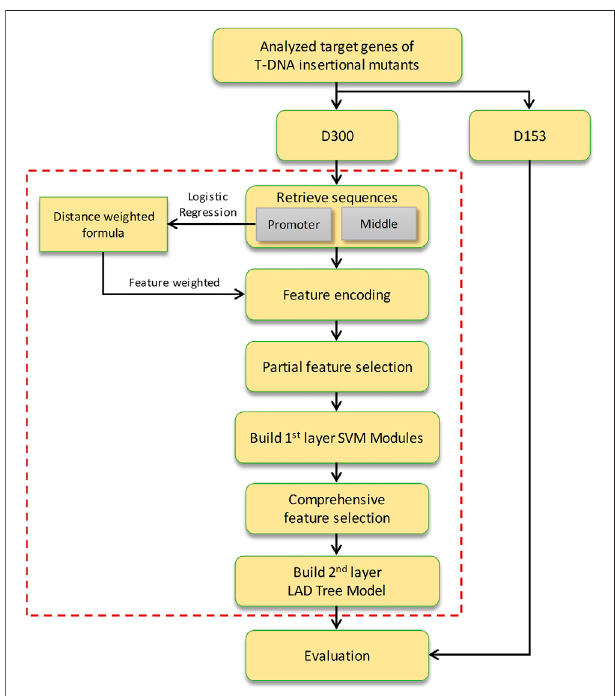
FIGURE 1 | Flow chart of the TIMgo predictive